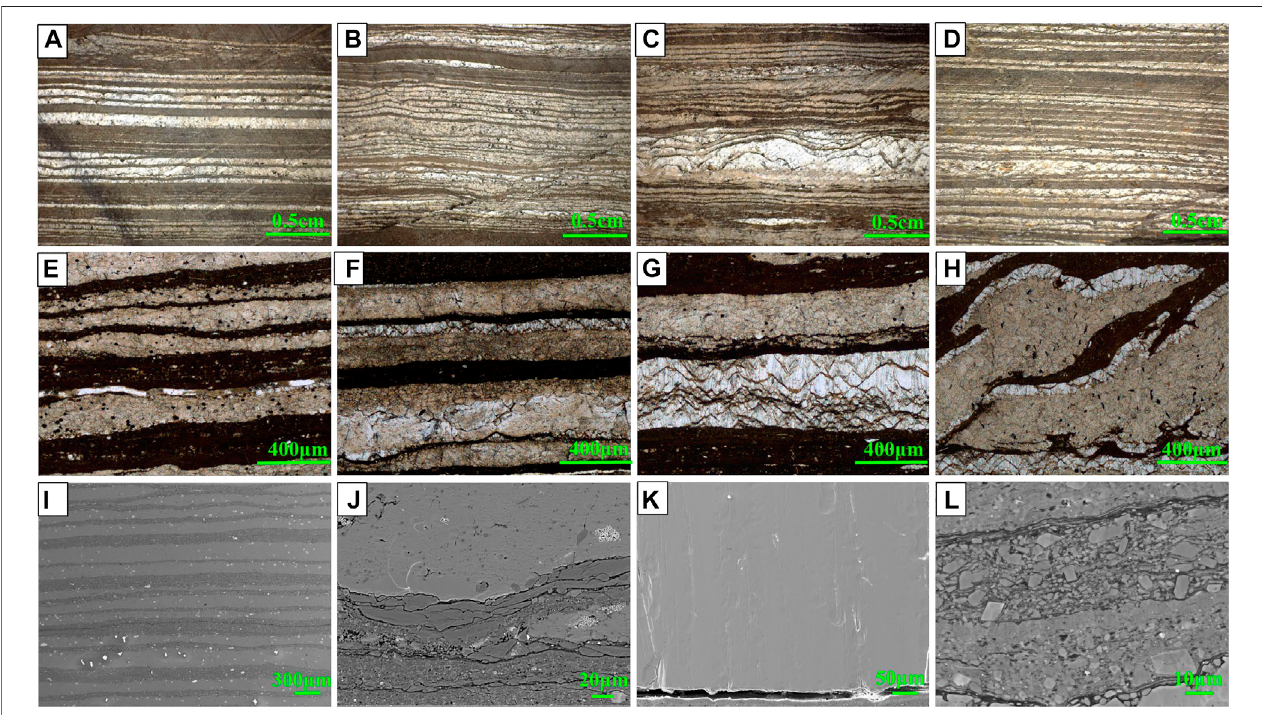
FIGURE 2 | Multi-scale carbonate interlayers within the organic-rich shale; (A – D) core photos of interbedded mudstones and shales with crystalline carbonates; (E – H) thin-section petrography under the cross-polarized light, with crystalline carbonate interlayers showing a well-crystalized morphology; (I) SEM image of interbedded mudstone and crystalline carbonate; (J) SEM image showing the boundary between layered mudstone and carbonate; (K) SEM image of well-crystallized carbonates with clean surface and bedding fracture; and (L) SEM image of layered mudstone and banded organic matter.